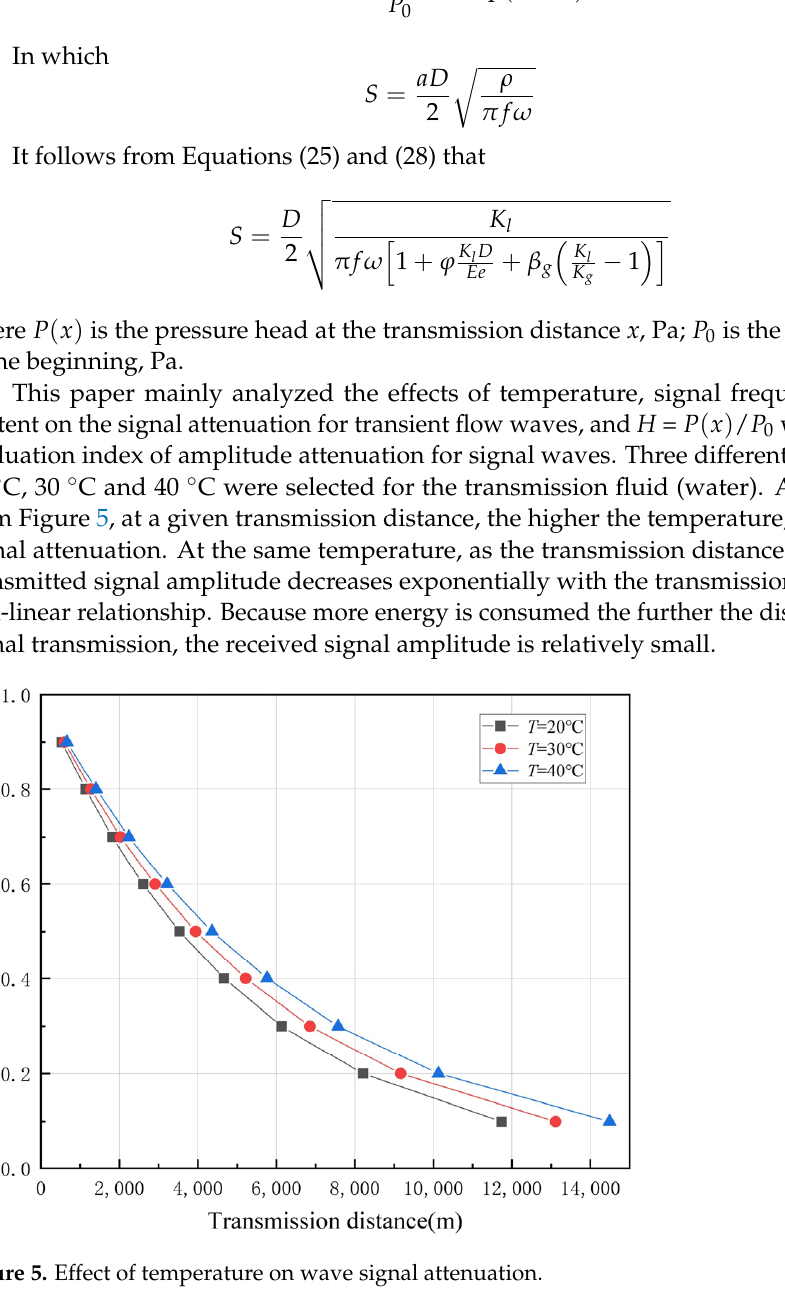
Figure 5. Effect of temperature on wave signal attenuation. Three signals with different frequency 1 Hz, 2 Hz and 3 Hz were selected. From Figure 6, it can be concluded that the frequency causes a nonlinear near-exponential decrease in wave transmission amplitude with the transmission distance at the same distance. The higher the frequency, the smaller the signal